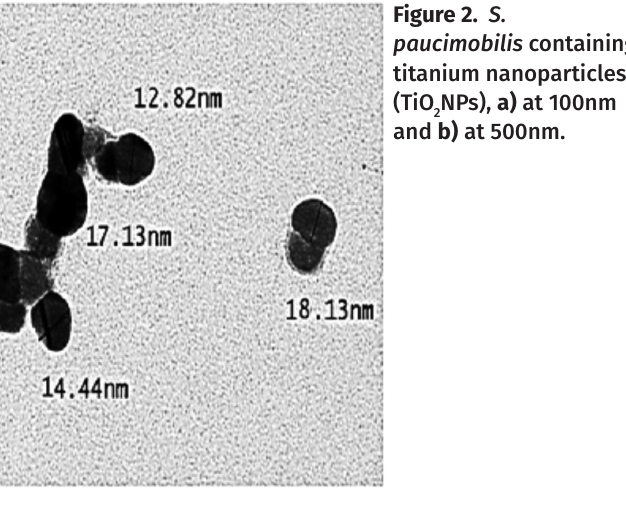
Figure 2. S. paucimobilis containing titanium nanoparticles (TiO NPs), a) at 100nm 2 and b) at 500nm.